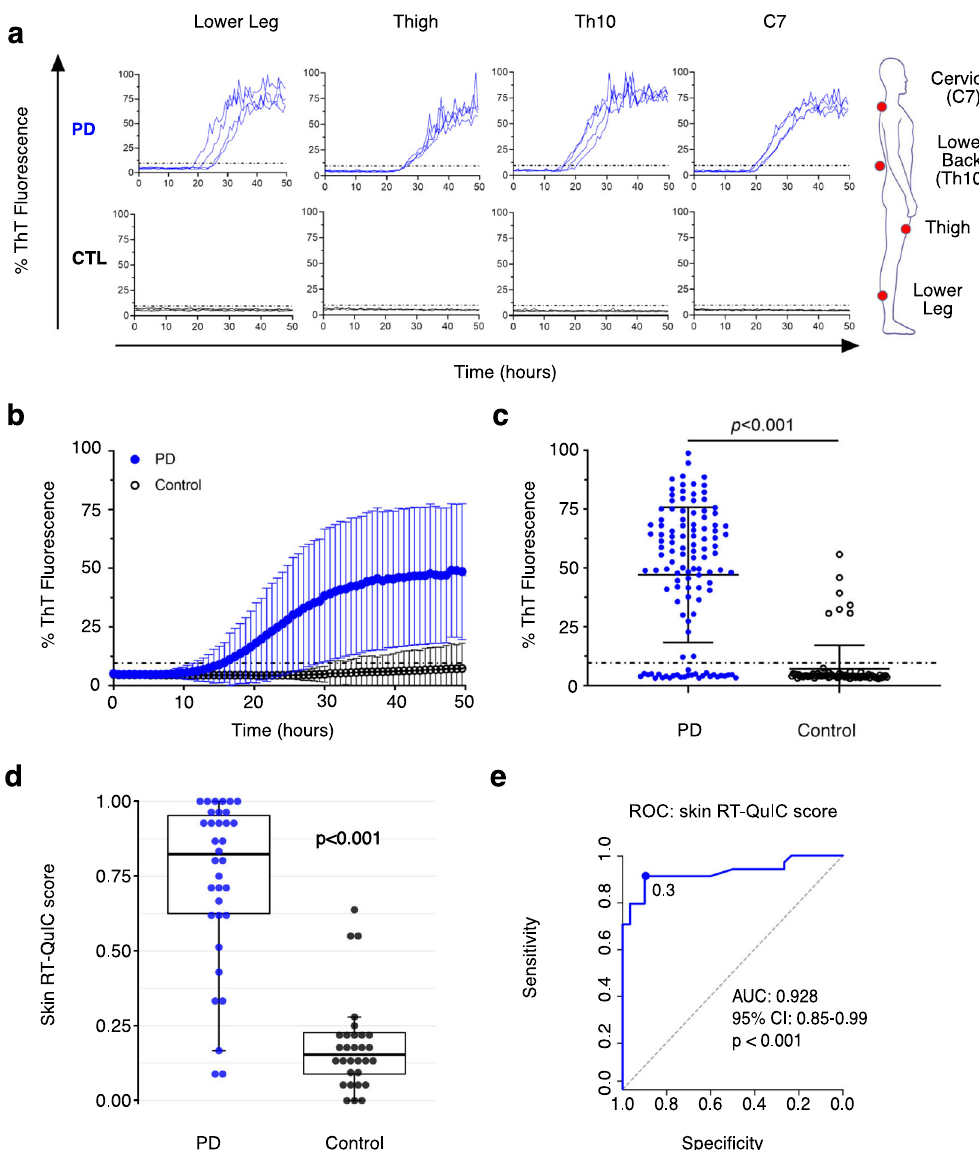
Fig. 1 RT-QuIC detection of α -syn seeding activity in skin biopsies from PD patients and control subjects. a α -Syn RT-QuIC assay of multiple skin biopsies from a PD patient (PD10) and a control subject (CTL2). Four skin biopsy sites at the level of C7 (neck), Th10 (lower back), thigh, and lower leg are indicated. Shown are individual ThT fl uorescence responses over time for each skin sample tested in quadruplicate. The dotted line indicates threshold at 9.6%. A marked increase of ThT fl uorescence over time is found in patient samples but not in the control samples. b Cumulative results of blinded testing of all skin biopsies by α -syn RT-QuIC (Cleveland center). Mean values (±SD) of percentage of ThT fl uorescence of all biopsies tested in quadruplicate are clearly increased in PD patients ( n = 34) compared to control subjects ( n = 30). The dotted line indicates threshold at 9.6%. c Scatter graph of fi nal percentage of ThT fl uorescence intensities (50 h) for all individual biopsies. Average ThT fl uorescence intensities of skin biopsies from PD patients ( n = 34 with 117 biopsies) are signi fi cantly higher ( p < 0.001) than those from control subjects ( n = 30 with 81 biopsies). Dots represent values of individual biopsies, the dotted line indicates threshold at 9.6%. Group mean ± SD are represented by solid lines. d Skin RT-QuIC scores in PD patients ( n = 34) and control subjects ( n = 30). Scores are pooled from both Cleveland and Würzburg centers. A box plot demonstrates signi fi cantly higher scores in PD compared to controls ( p < 0.001). The horizontal line in the box plot marks the median, the box represents the interquartile range (IQR), and the whiskers extend to the most extreme data point, which is no more than 1.5 times of IQR. e Receiver operating characteristic (ROC) curve and the corresponding area under the curve (AUC) for skin RT-QuIC scores. ROC analysis demonstrates an optimal RT-QuIC score threshold of 0.3 that would result in a 91.2% sensitivity and 90.0% speci fi city. CI con fi dence revealed that α -syn seeding activity persisted in more diluted reactions were positive. This allowed for a quantitative comparison skin lysates in patients with a long disease duration as compared of α -syn seeding activity (in SD 50 units) among specimens from to those with a short duration (Fig. 5a), with SD 50 values being different patients, similar to the measures used in bioassays 18 . Serial dilutions of skin biopsies at C7, Th10, and thigh from PD fourfold higher in the long duration patients (Fig. 5b; median patients with shorter (5 – 7 years, n = 3) and longer (15 – 28 years, n SD 50 /mg, 2430 units for long duration vs 616 units for short = 4) disease duration were performed. Parallel comparisons duration; p = 0.0083).